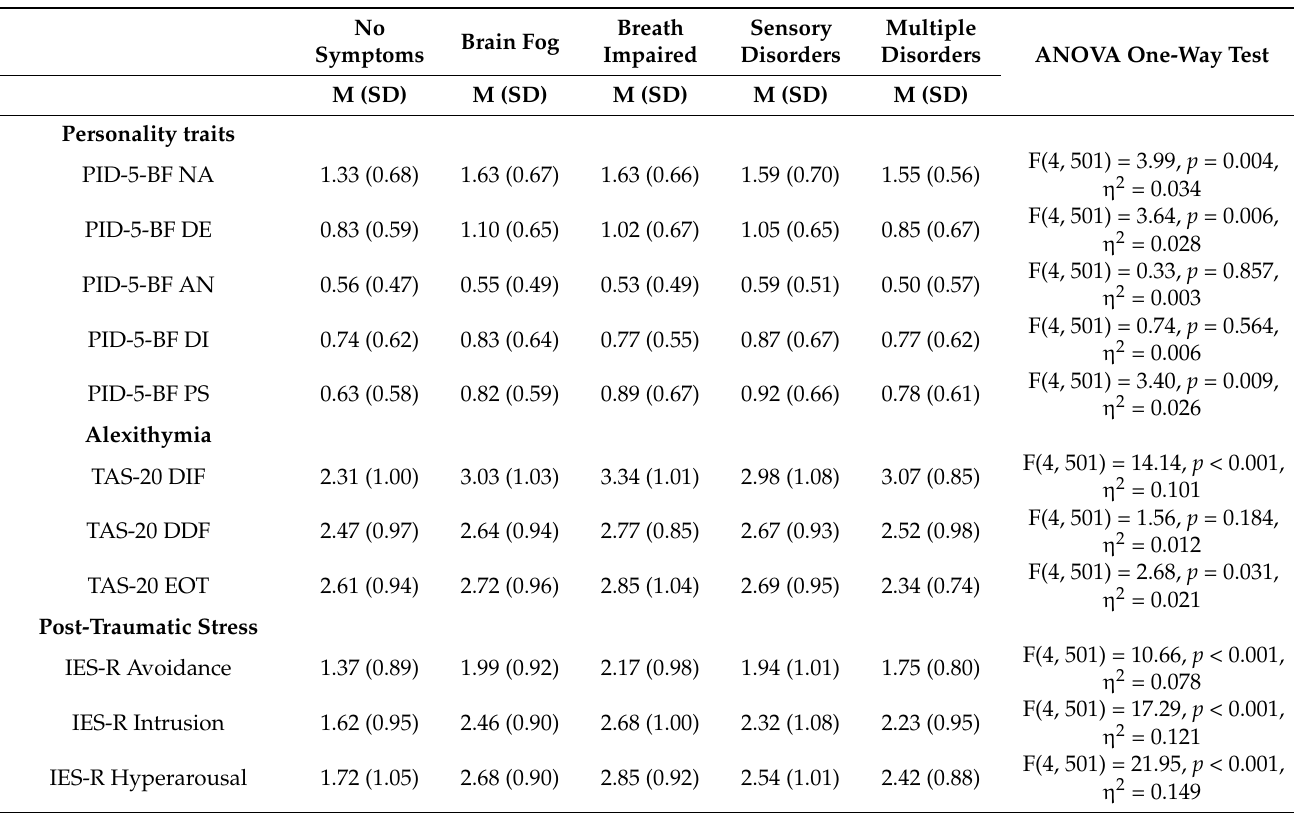
Table 4. Means, standard deviations, and one-way analyses of variance in personality traits, alex- ithymia, and post-traumatic stress ( N =